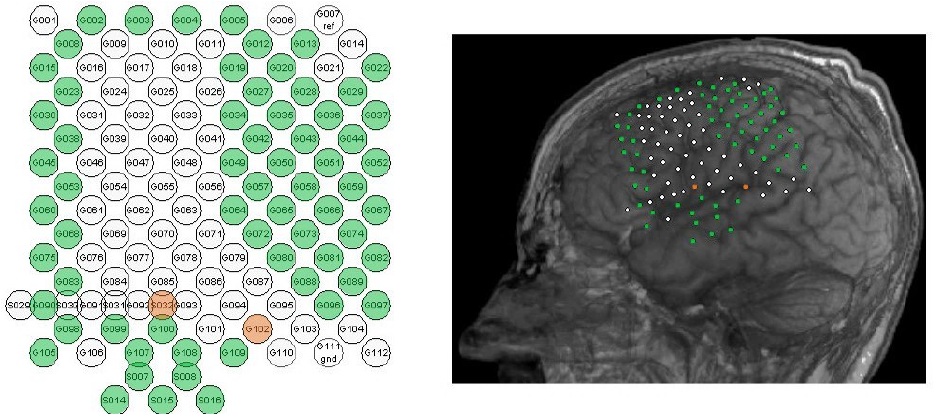
Figure 1. ECoG channels positions. Left : channel names, with functional recording channels shown in green, and ground (S032) and reference (G102) channels in orange. Right : spatial location of surgically implanted ECoG grid electrodes.